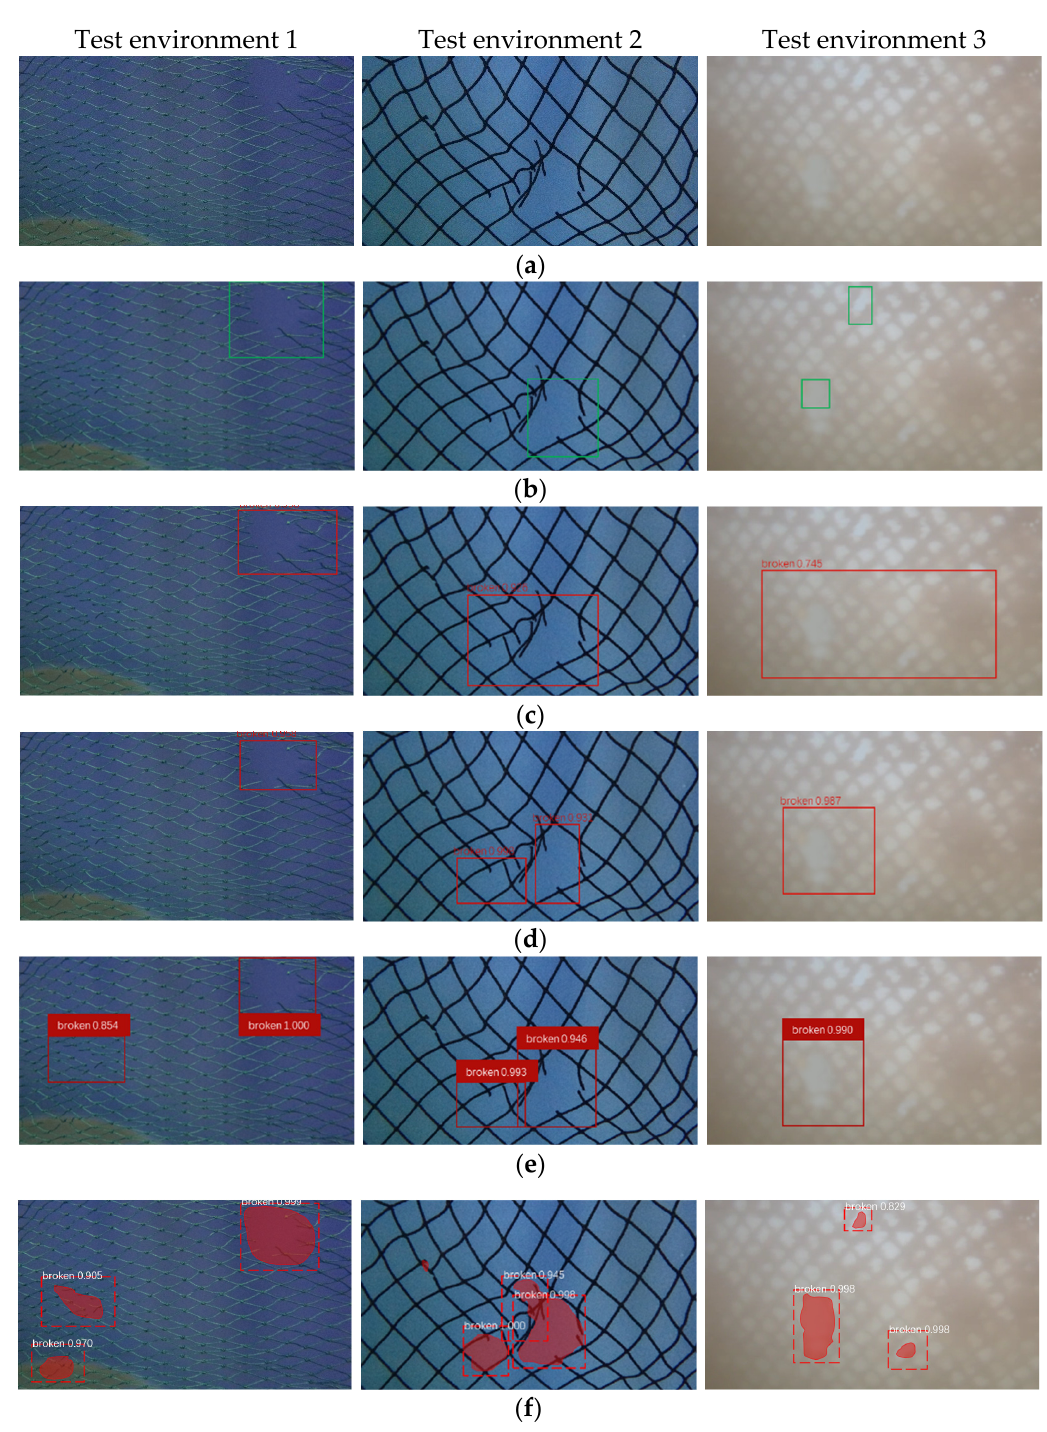
Figure 12. Comparison of detection effects of different models under different environments. ( a ) Original images, ( b ) OpenCV, ( c ) SSD, ( d ) YOLOv3, and ( e ) Cascade R-CNN. ( f ) Our model.